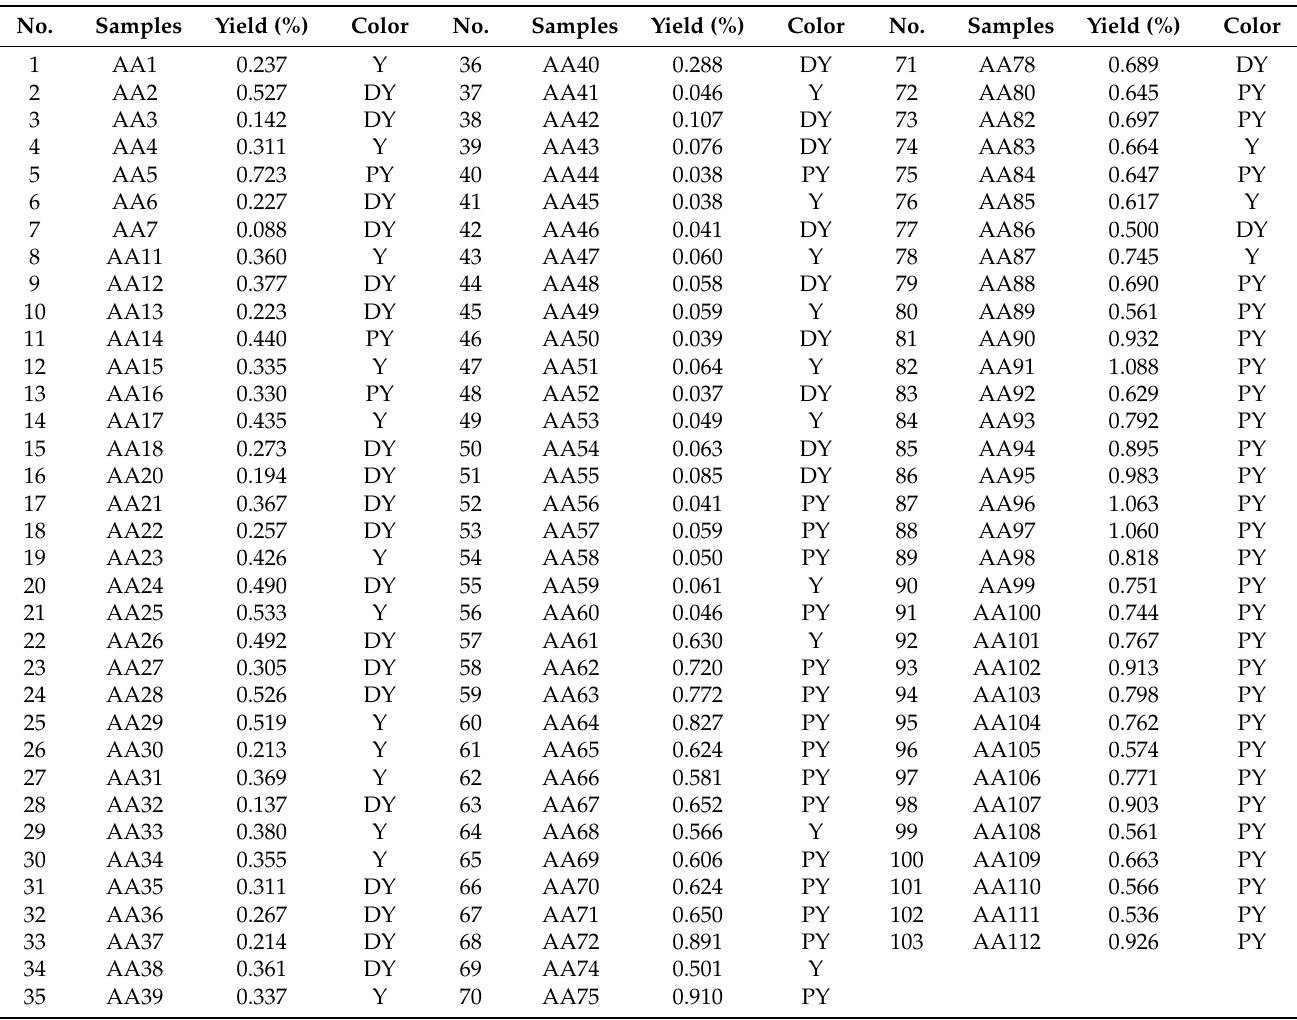
Figure 1. The color classification of A. annua essential oils. ( a ) pale yellow; ( b ) yellow; ( c ) dark yellow. Table 1. The yield ( v / w %) and color of essential oils from Korean A. annua